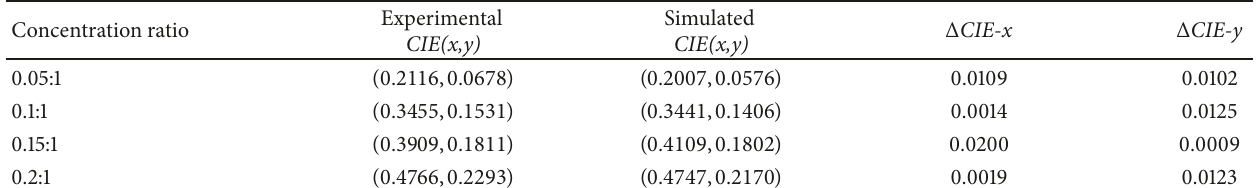
Table 3: Color coordinates of experiment and simulation at different mass ratios of phosphor films.